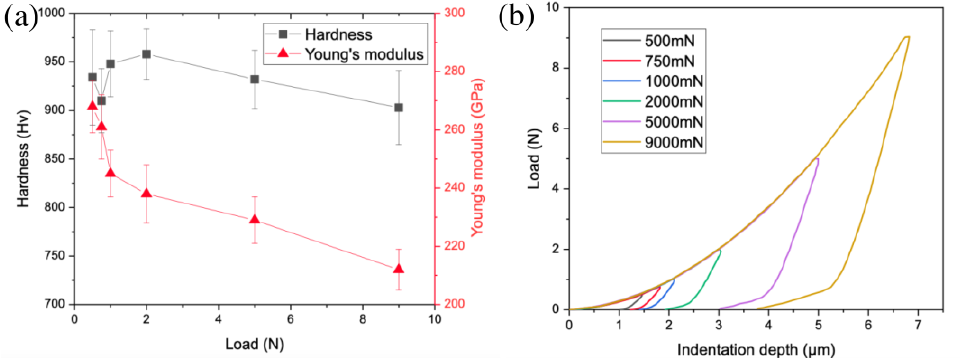
Figure 6. Mechanical properties investigations: ( a ) hardness and Young’s modulus as a function of indentation load; ( b ) indentation curves under different loads.